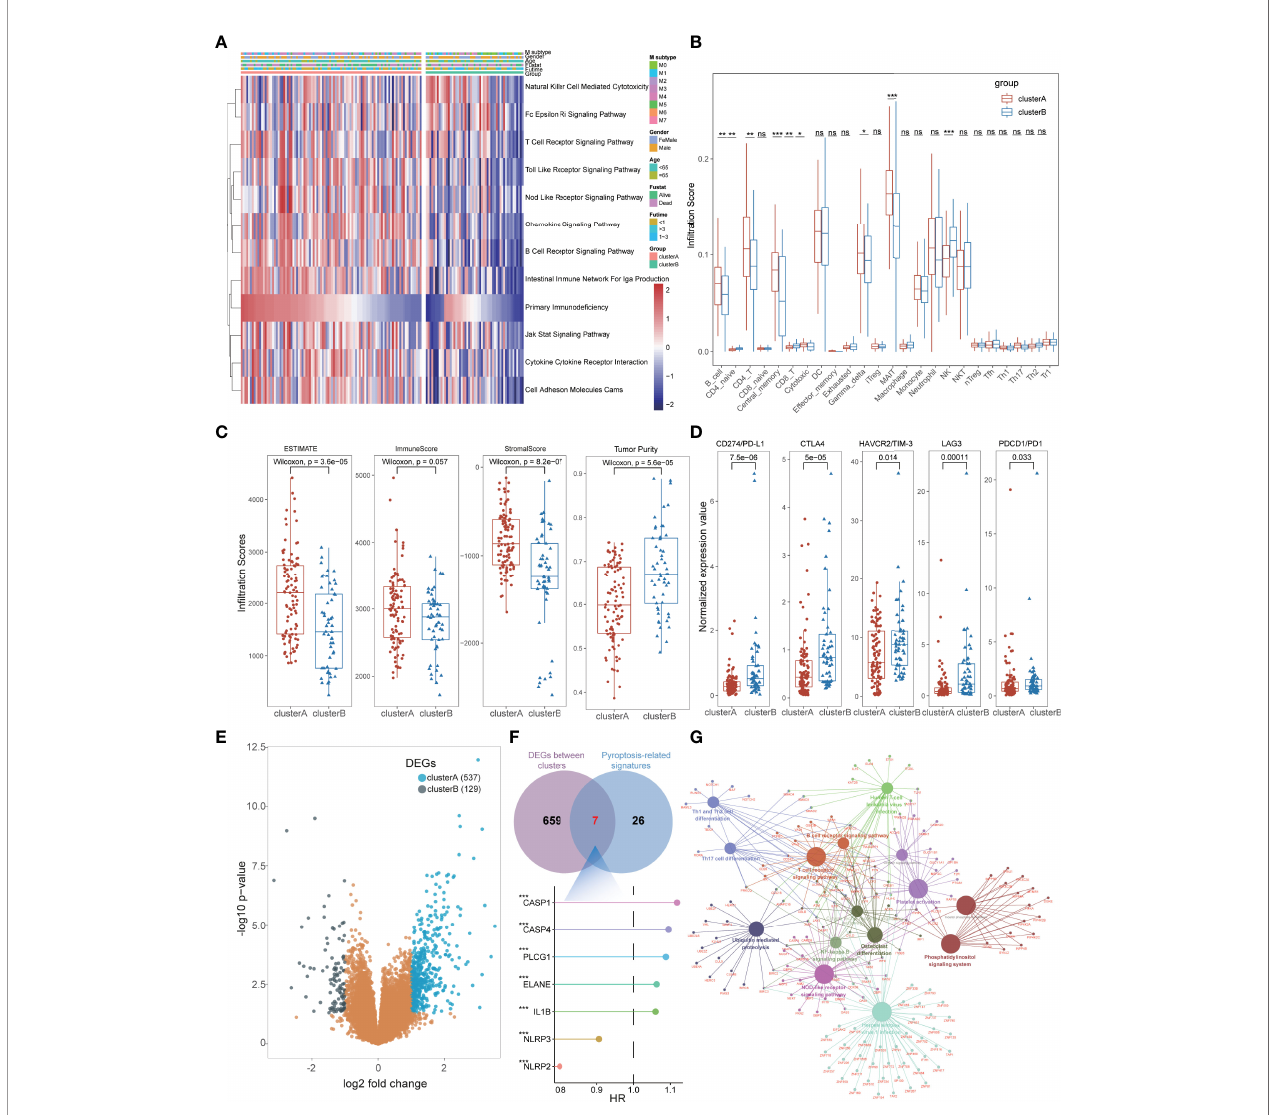
FIGURE 4 | The immunological characteristics of subtypes in AML patients. (A) GSVA indicated that immune-related pathways were signi fi cantly activated in cluster A groups. (B) Massive immune cells also in fi ltrated the bone marrow tissues of cluster A with higher levels than those in cluster (B, C) TME analysis detected higher stromal and immune scores with lower tumor purity in cluster A patients. (D) Higher expression of immune checkpoints was found in cluster B, including PD1, PD- L1, CTLA4, HAVCR2, and LAG3. (E) A total of 666 DEGs were identi fi ed including 537 DEGs for cluster A and 129 DEGs for cluster (B, F) Seven pyroptosis-related DEGs were identi fi ed with signi fi cant prognostic value for AML patients. (G) KEGG enrichment analysis showed that cluster A-associated DEGs were enriched in the above immune-activated associated pathways. *P<0.05, **P<0.01, ***P<0.001; ns, not signi fi